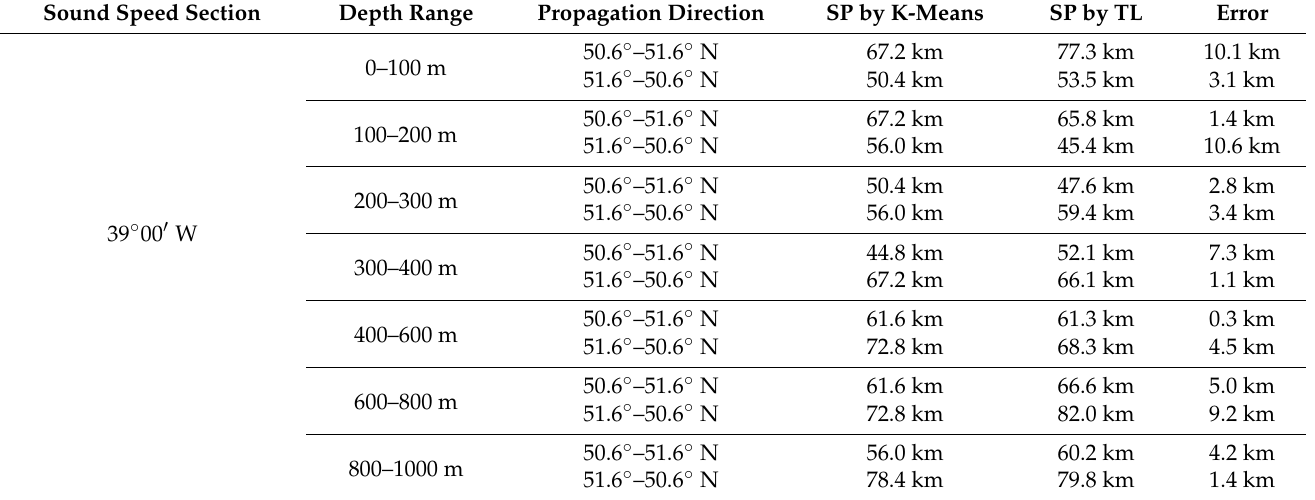
Table 2. The comparison of the accuracy of the K-means algorithms on the identification of the frontal zone in different depth ranges at 39 ◦ 00 (cid:48) W section (SP by K-means means the starting point of the frontal zone obtained by K-means, SP by TL means the starting point of the frontal zone obtained by calculating the TL, Error means the difference between SP by K-means and SP by